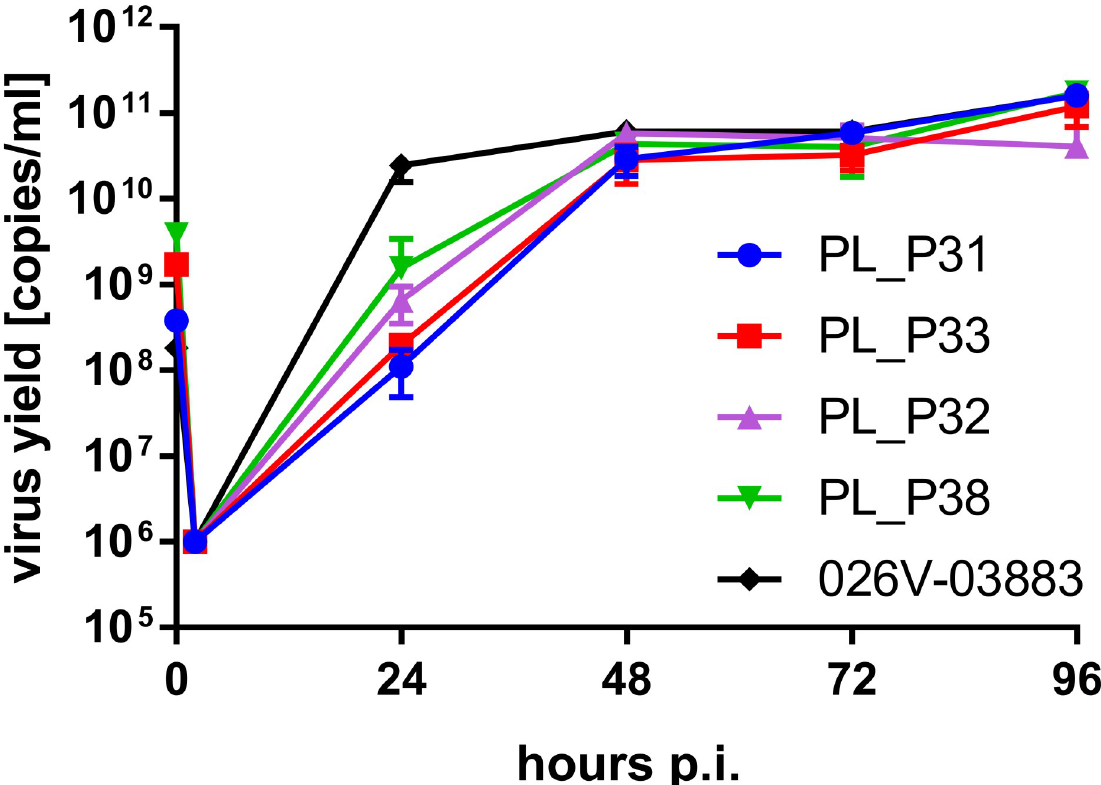
Fig 2. Replication kinetics of the SARS-CoV-2 strains. Virus yield was determined with RT-qPCR, and the data is presented as a mean ± SD. The EVAg strain was used as a